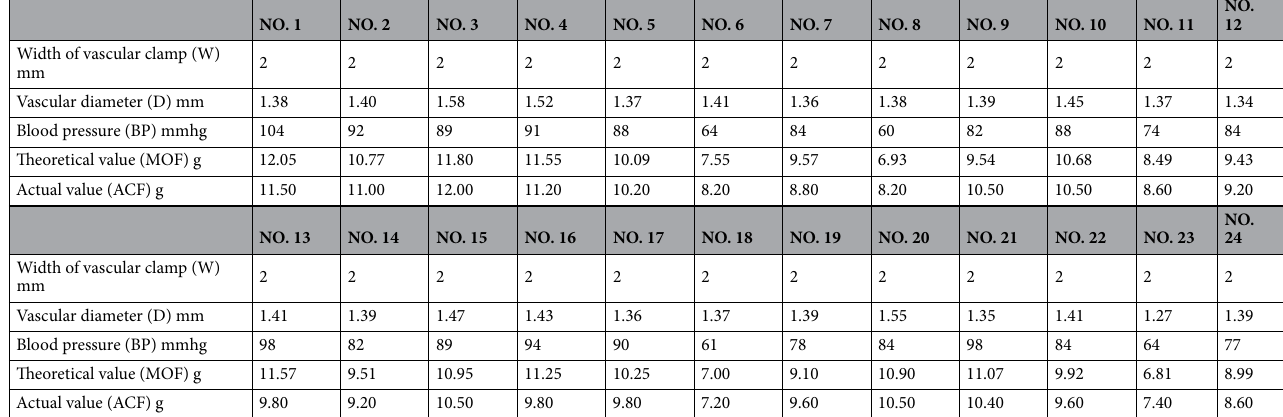
Table 1. Summary of theoretical and actual minimum occlusive force in 24